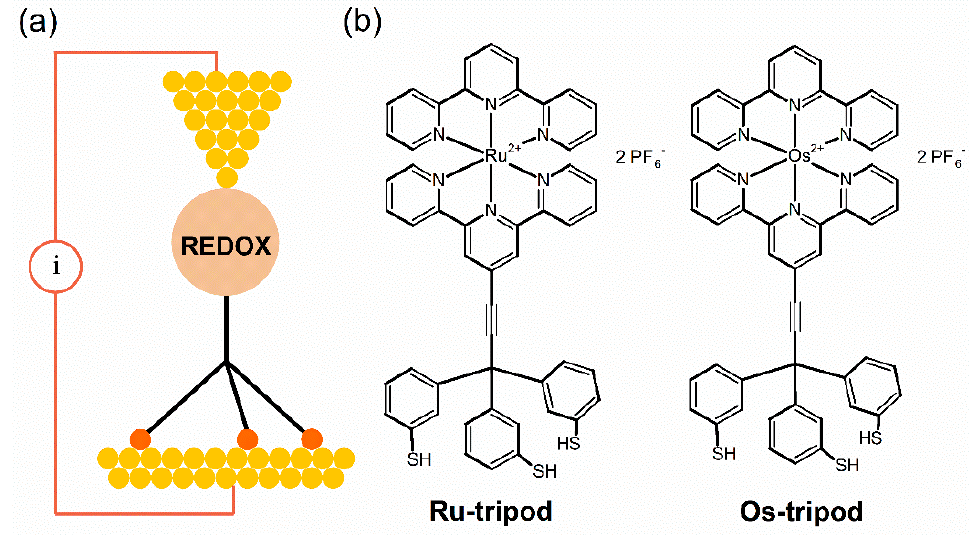
Figure 1. ( a ) Schematic arrangement of molecule with [M(tpy) 2 ] 2+ redox center in STM experiment; ( b ) chemical structure of Ru-tripod and Os-tripod molecules.